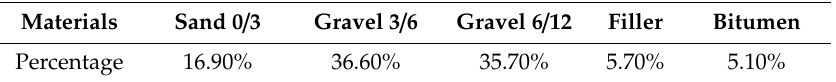
Table 4. Asphalt composition